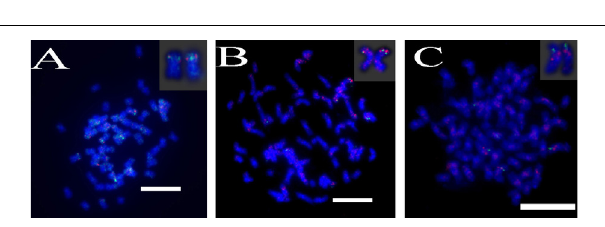
FIGURE 5 | FISH mapping of BAC-69, BAC-71, BAC-73, BAC-77 on SsChr2 in S. spontaneum . (A) BAC-71 and BAC-69 probes; (B) BAC-73 and BAC-69 probes; (C) BAC-71 and BAC-77 probes labeled with biotin (green) and digoxigenin (red). Scale bars = 10 µ m.